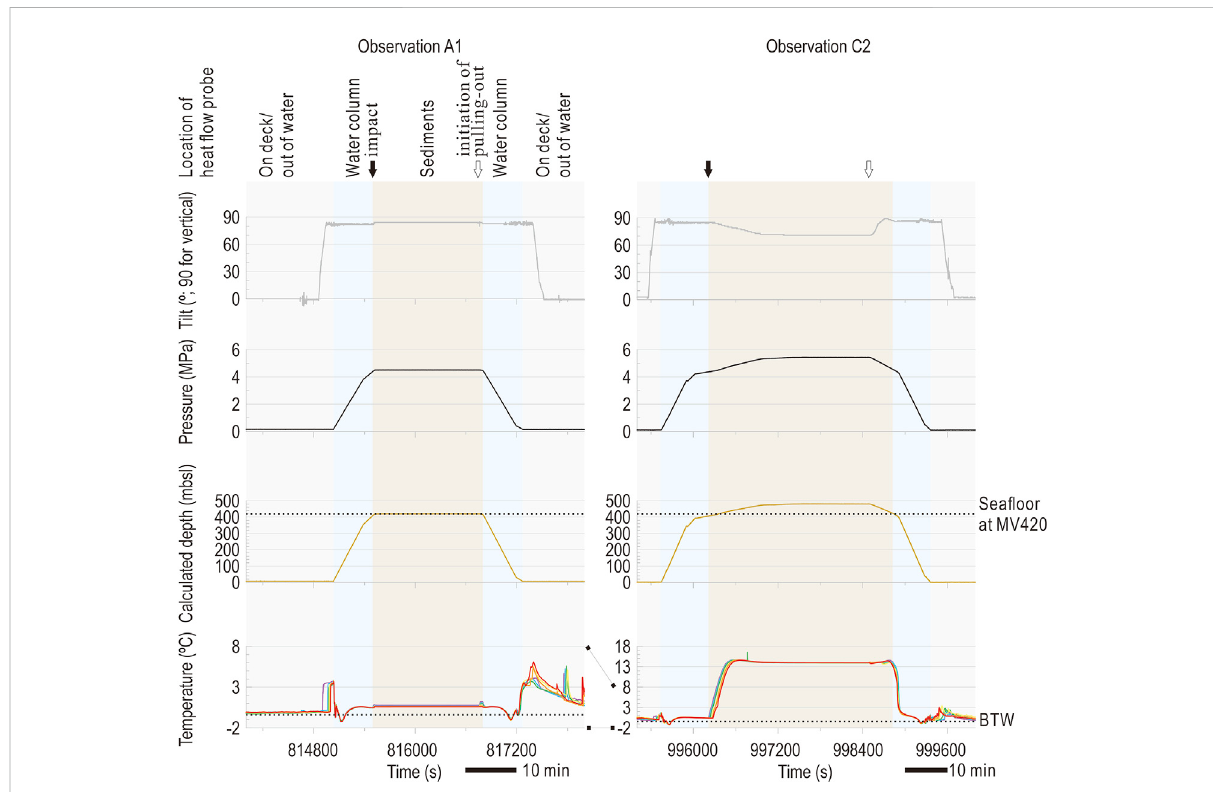
FIGURE 3 Comparison of heat fl ow measurements in normal penetration and overpenetration. Analysis of time series of tilt ( fi rst row) pressure (second row), andtemperature(fourth row)recordings allowsthelocation oftheheat fl owprobe to bediscriminated. The timingofimpact(black arrow) and initiation of pulling out (white arrows) of the heat probe can be identi fi ed from the abrupt changes in temperature and tilt readings. In the case of overpenetration, it takes more time for the heat probe to escape sediments after the initiation of pulling out. The depth (third row) is converted from the pressure data (see text). Water depth 420 and bottom water temperature are stated in the third and fourth rows. The heat probe was left in the sediment for at least 20 min after penetration/impact. The horizontal scale bar is 10